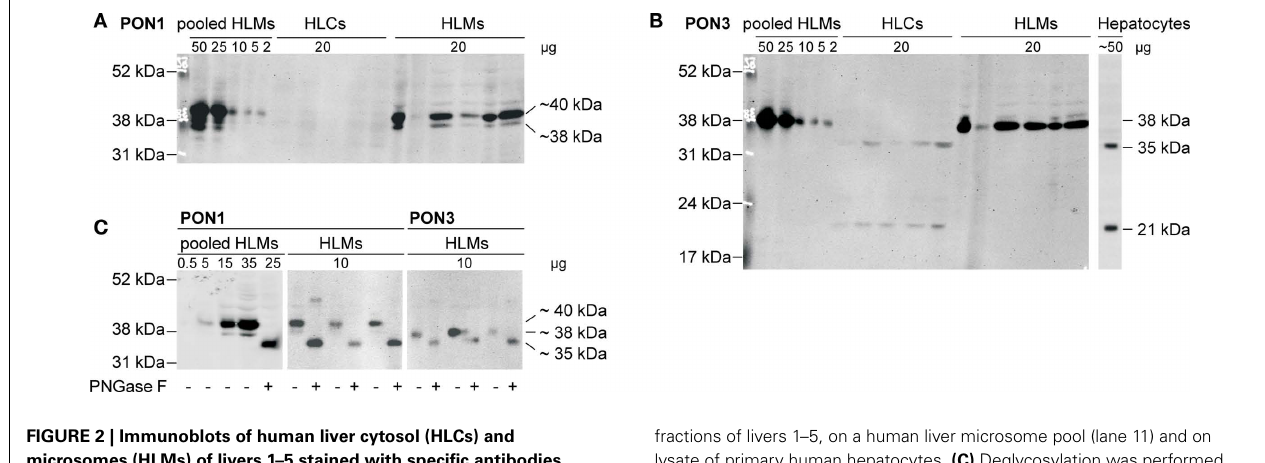
FIGURE 2 | Immunoblots of human liver cytosol (HLCs) and microsomes (HLMs) of livers 1–5 stained with specific antibodies against (A) PON1 and (B) PON3 (performed on identical blot after stripping). Analysis was performed on cytosolic and microsomal